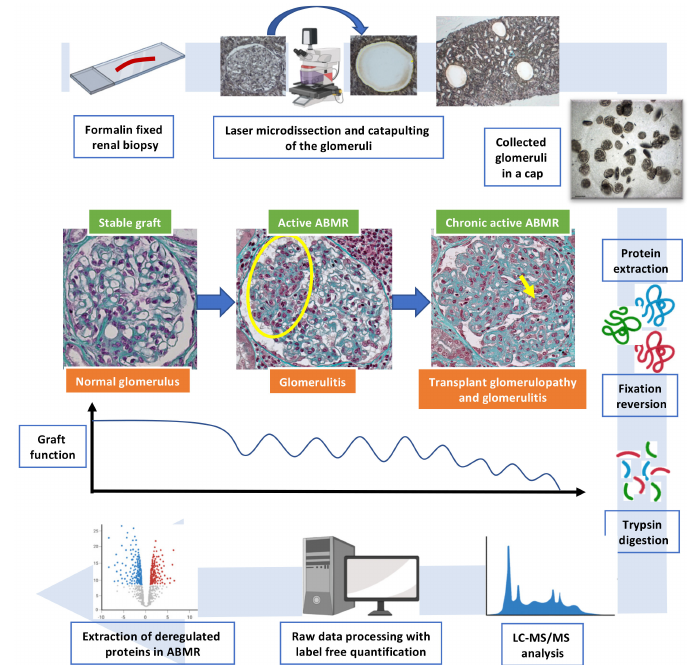
Figure 1. Overall analytical strategy of the study. The histological hallmark of kidney active antibody- mediated rejection is glomerulitis i.e., inflammatory cells within the glomerular capillary loops. This lesion can be seen by light microscopy (yellow circle and arrow, Masson’s trichrome staining, original magnification × 400). Prolonged injuries lead to an expansion of the extracellular matrix (stained in green with Masson’s trichrome) and a duplication of the glomerular basement membrane called transplant glomerulopathy. These lesions are associated with graft dysfunction, proteinuria and ultimately allograft loss. Herein we performed a bottom-up proteomic approach on laser microdissected glomeruli during active ABMR, chronic active ABMR and stable graft patients from formalin-fixed and paraffin-embedded allograft biopsies. The key technical steps are presented by following the blue arrow. Abbreviations: ABMR, antibody-mediated